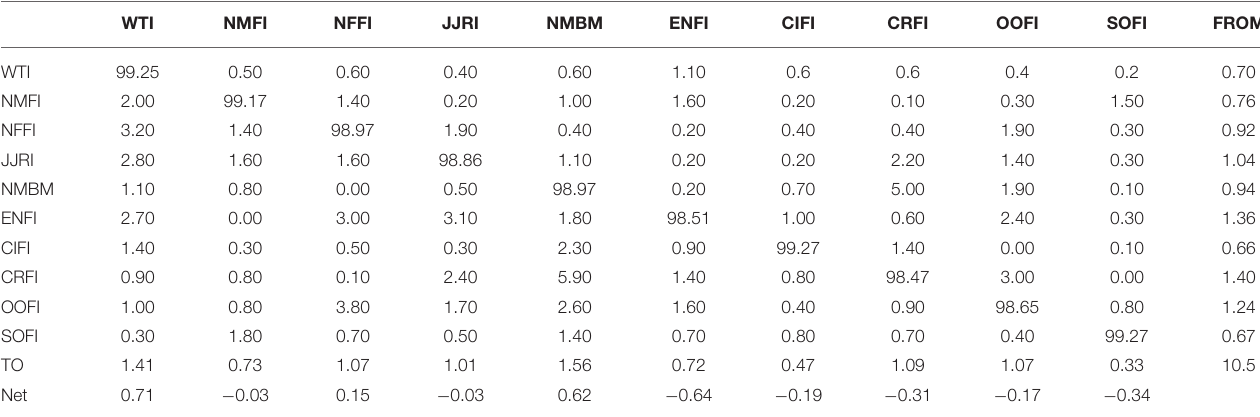
TABLE 3 | Volatility spillover results of the